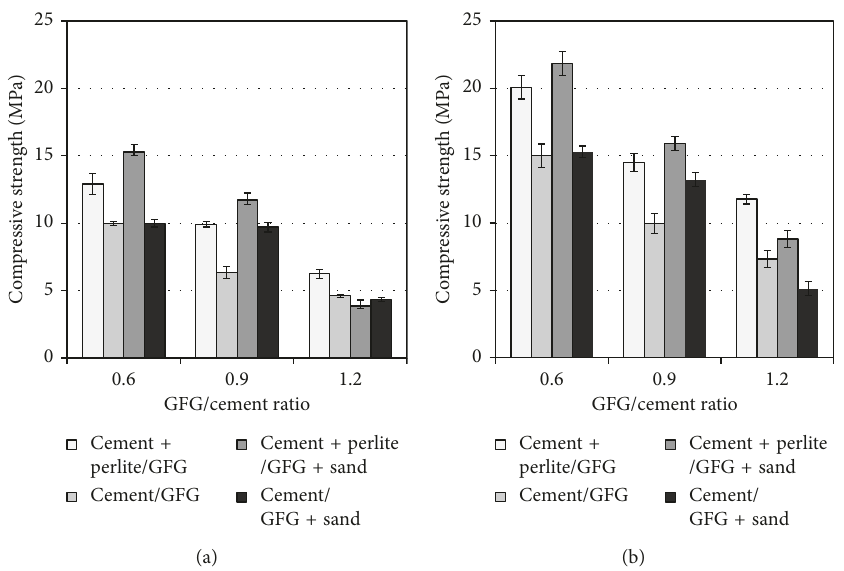
Figure 9: Compressive strength of mortars after 48h (a) and 28 days (b) of